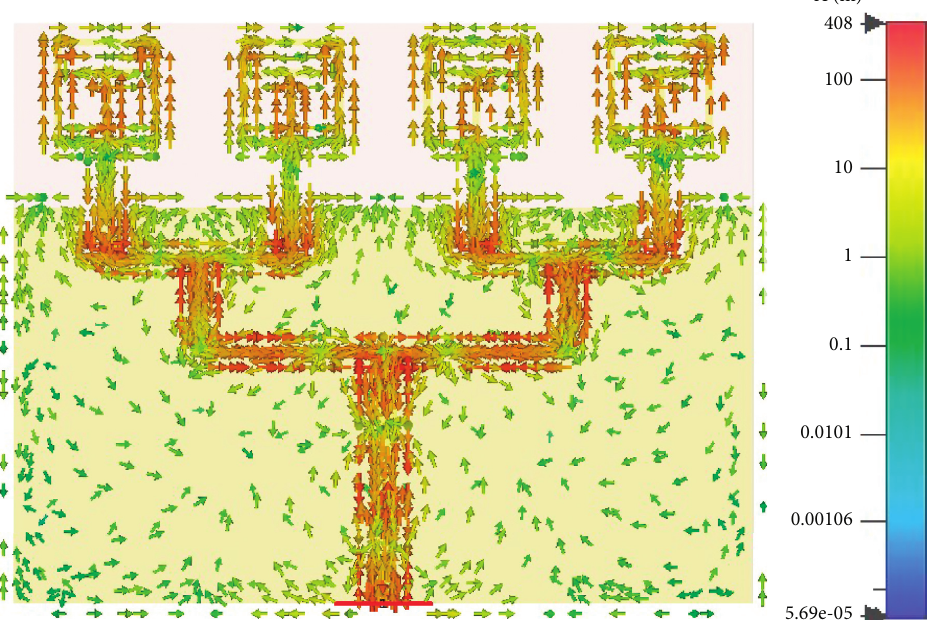
Figure 6: Surface current distribution at